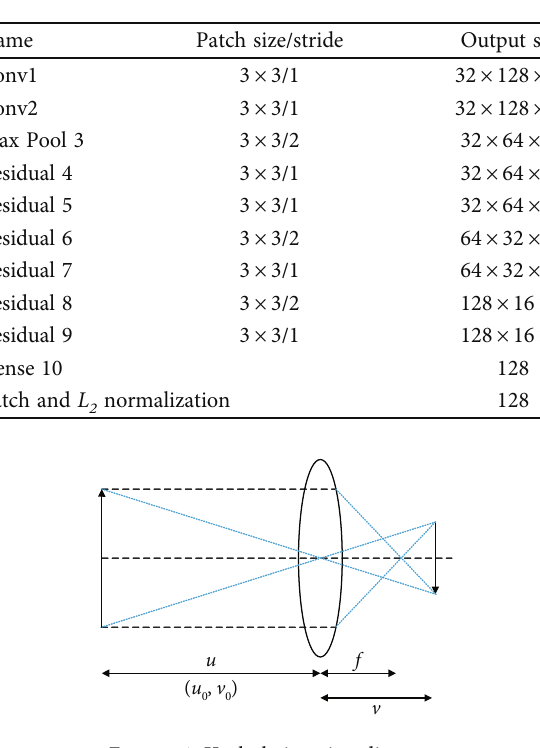
Table 1: Overview of the ReID